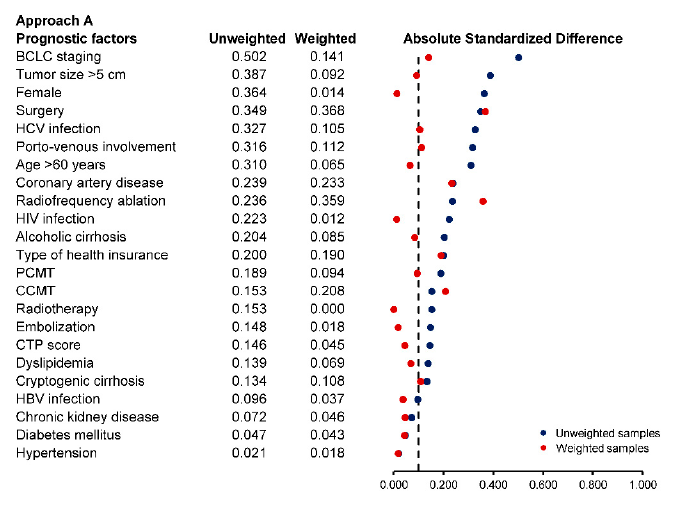
Figure 1. Balance in prognostic factors at baseline for approach A (conventional cohort analysis) based on absolute standardized difference in the unweighted and weighted samples. Table 3. Primary study endpoints (restricted mean survival time) via two analytic approaches. Palliative Consultation